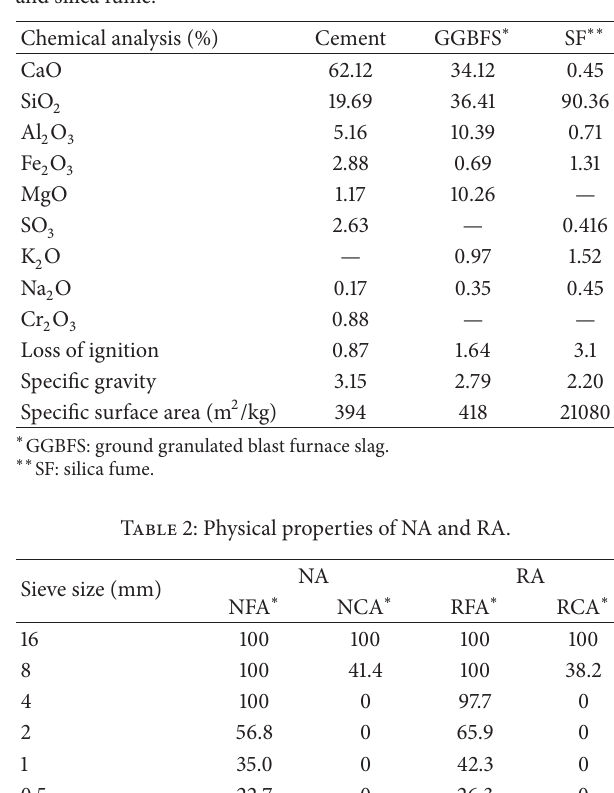
Table 1: Properties of cement, ground granulated blast furnace slag, and silica fume.